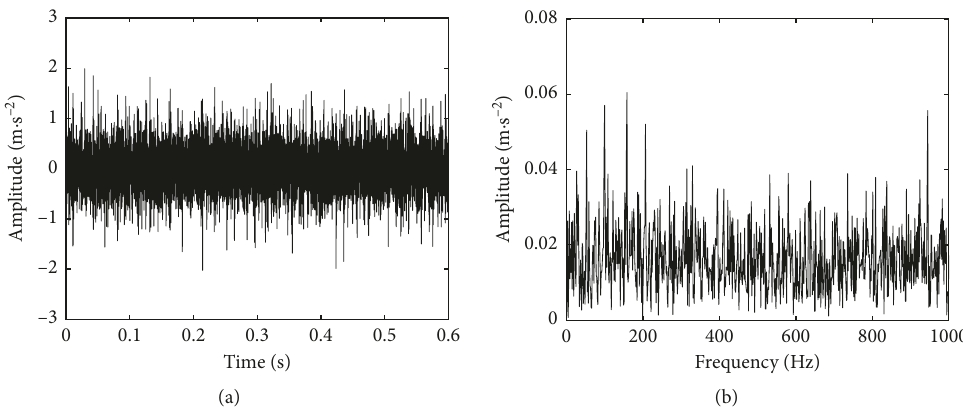
Figure 4: Fault signal with strong noise. (a) Waveform in the time domain. (b) Envelope frequency spectrum.